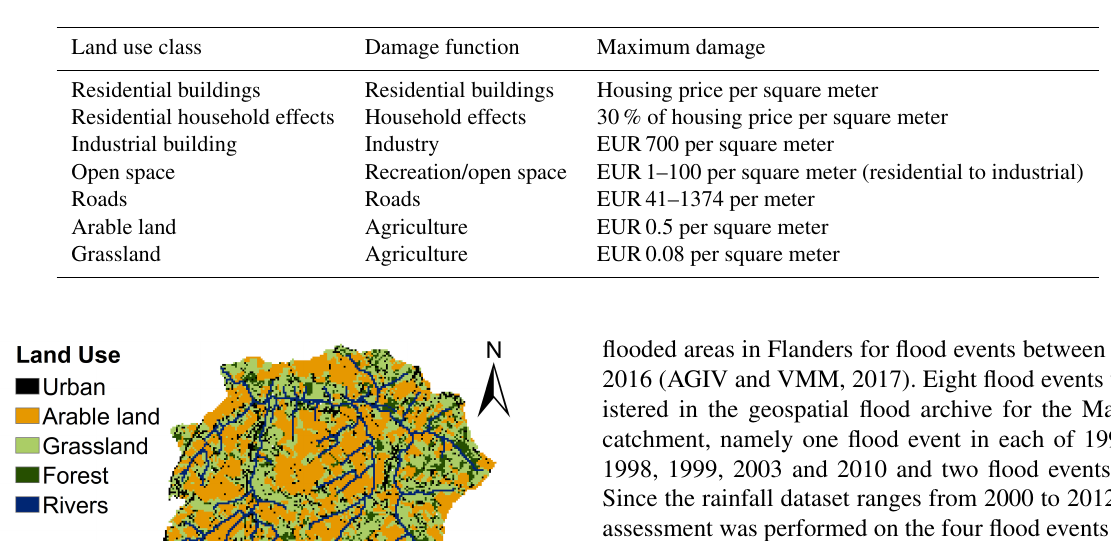
Table 1. The maximum damage values as implemented in the flood damage model and derived from Beullens et al. (2017), Koks et al. (2014) and Vanneuville et al. (2006).